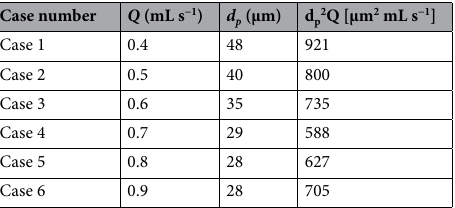
Table 1. Measured mean diameters of the aerosol droplets for different flow rates.